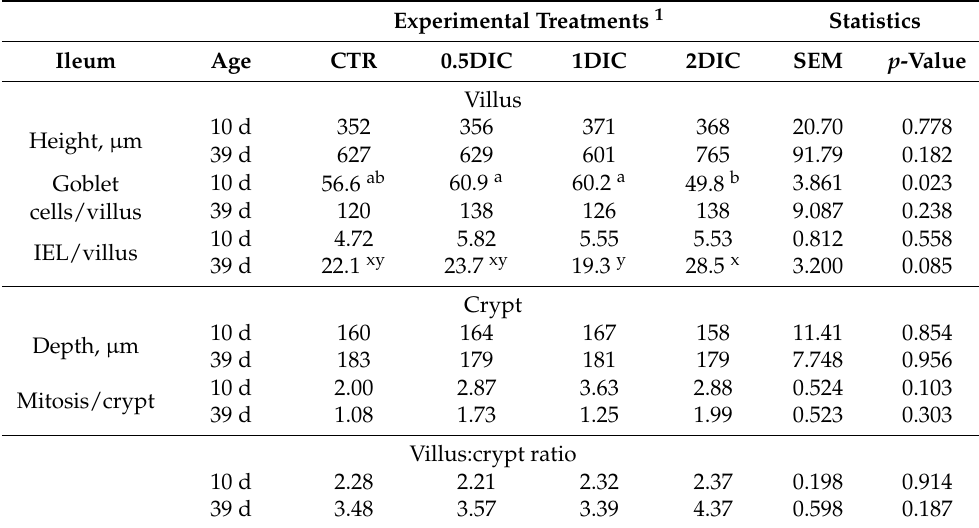
Table 4. Effects of dietary DIC supplementation level on histomorphological parameters recorded in the ileum of 10-day-old and 39-day-old broiler chickens (Experiment 1). Experimental Treatments 1